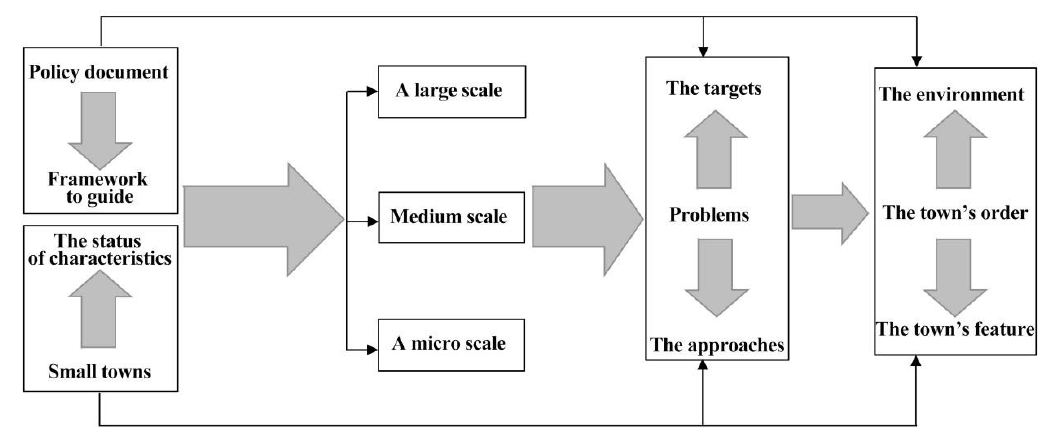
Fig. 1 Planning and control system of small town